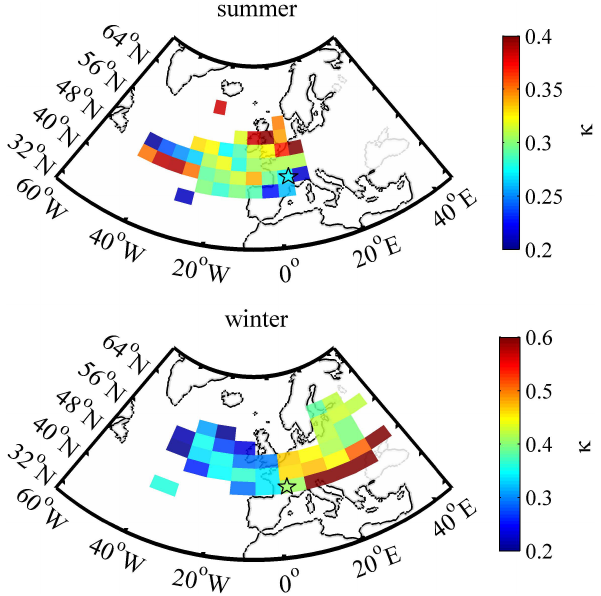
Fig. 8. CCN 0 . 24 to total CN ratios with the air mass origin dur- ing summer (up) and winter (down). The star marks the location of the measurement site. For details of the calculations, see Sect. 3.3: aerosol CCN properties by air